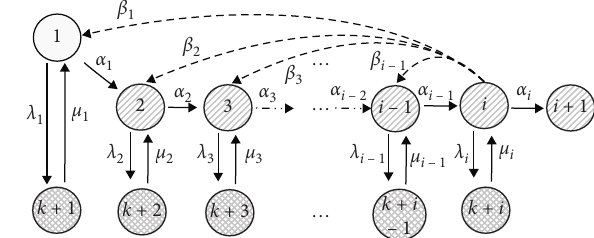
Figure 2: Simplified state transition